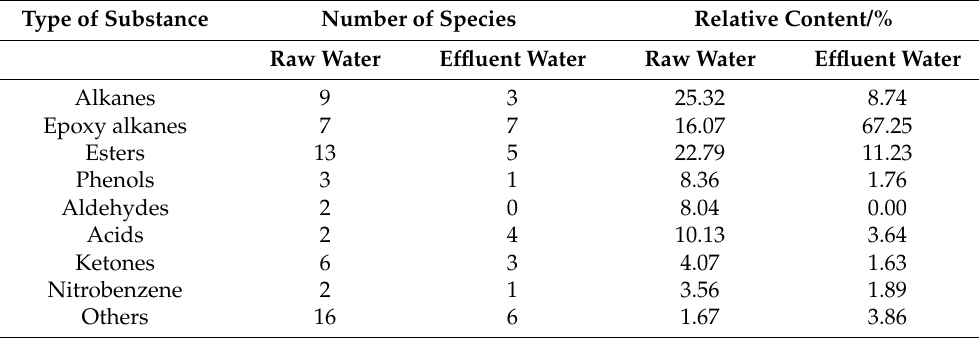
Table 3. Summary of main organic compound categories (mass percentage) by GC/MS analyses of treated water from each